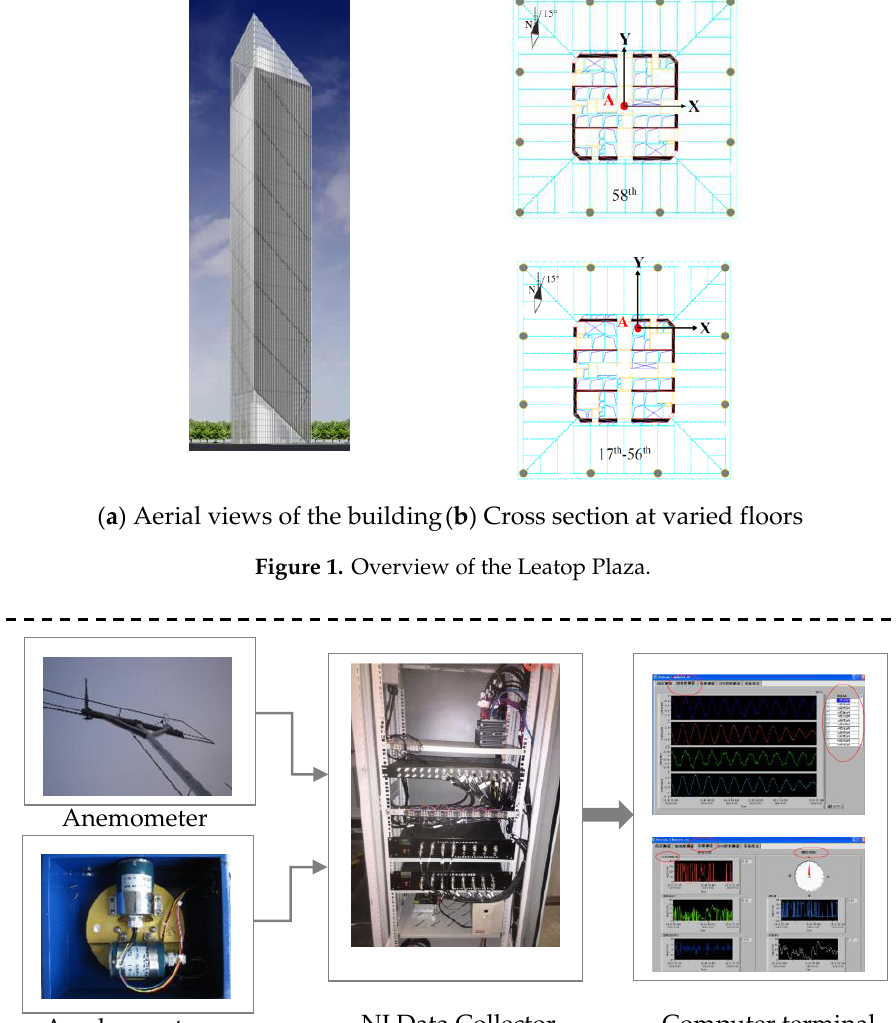
Figure 1. Overview of the Leatop Plaza.